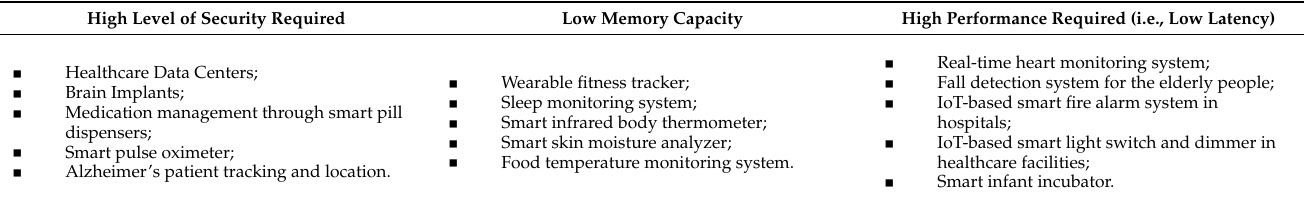
Table 15. Requirements and Application Examples.